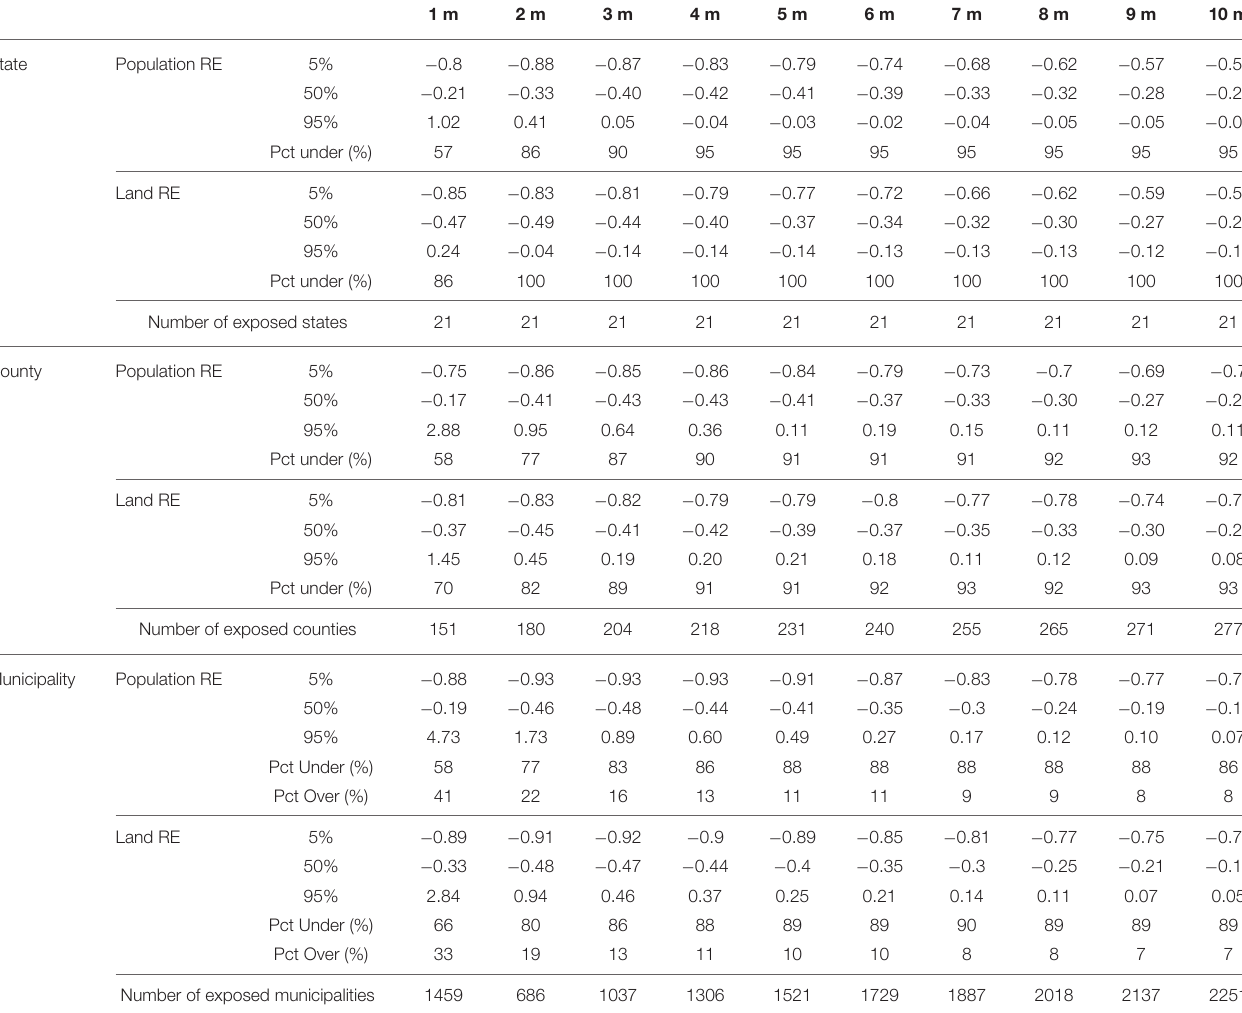
TABLE 1 | Relative error values at the 5/50/95th percentiles across exposed states, counties, and towns under SRTM-1. 1